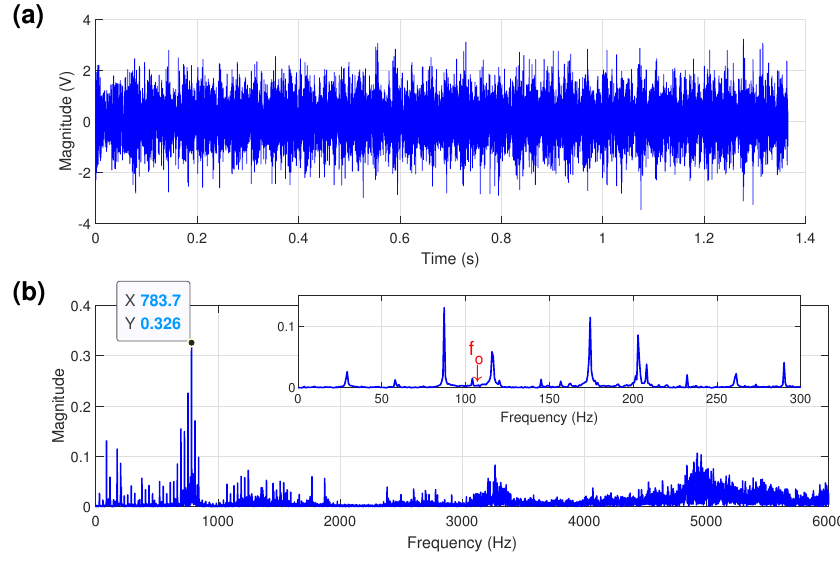
Figure 6. Faulty outer-race bearing: ( a ) time signal; ( b ) amplitude spectrum. To verify the effectiveness of the proposed method in bearing fault detection, the FK and the Autogram methods were used to analyze the same experimental bearing vibration signal for comparisons. The plot of the FK for the faulty outer-race bearing signal is shown in Figure 7a, giving optimal demodulation band parameters of the center frequency of 937 Hz and the bandwidth of 375 Hz. As shown in Figure 7b, the corresponding SES based on the selected band is totally dominated by the harmonics of the input shaft speed, about 29 Hz, throughout the spectrum and fails to diagnose the outer-race bearing fault. Figure 7c shows the Autogram for the faulty outer-race bearing signal, which gives